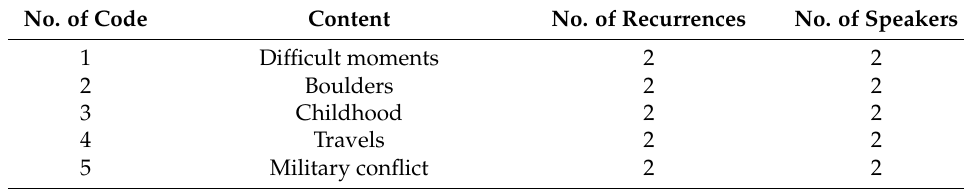
Table A3. Category C: Associations.